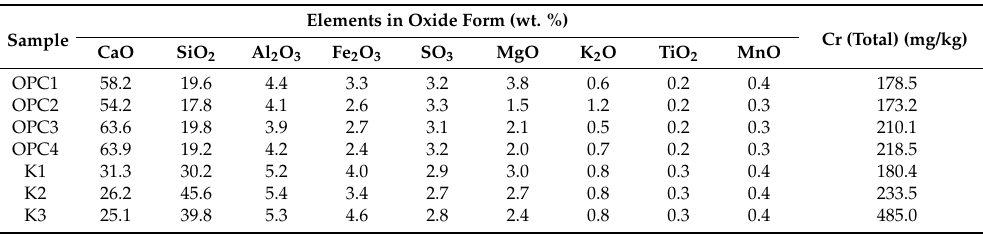
Table 2. Portland cement and composite